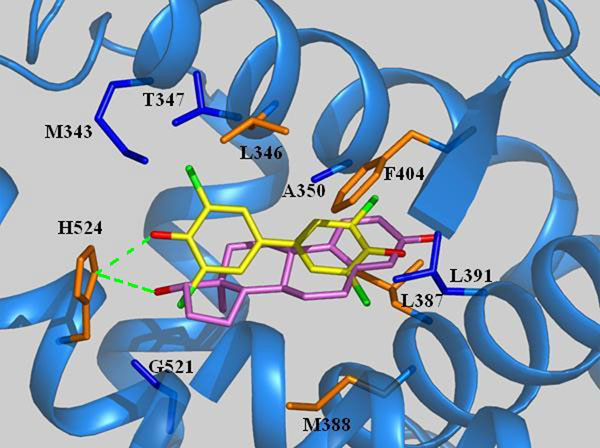
Predicted binding of PCB-OH with hERα. Yellow: PCB-OH, Violet : estradiol; ligand oxygen atoms are in red, and chlorine atoms in green. Aminoacids color code: orange: residues involved in ligand binding common to estradiol and PCB-OH; blue: PCB-OH specific interaction.Green dashed lines: hydrogen bonds